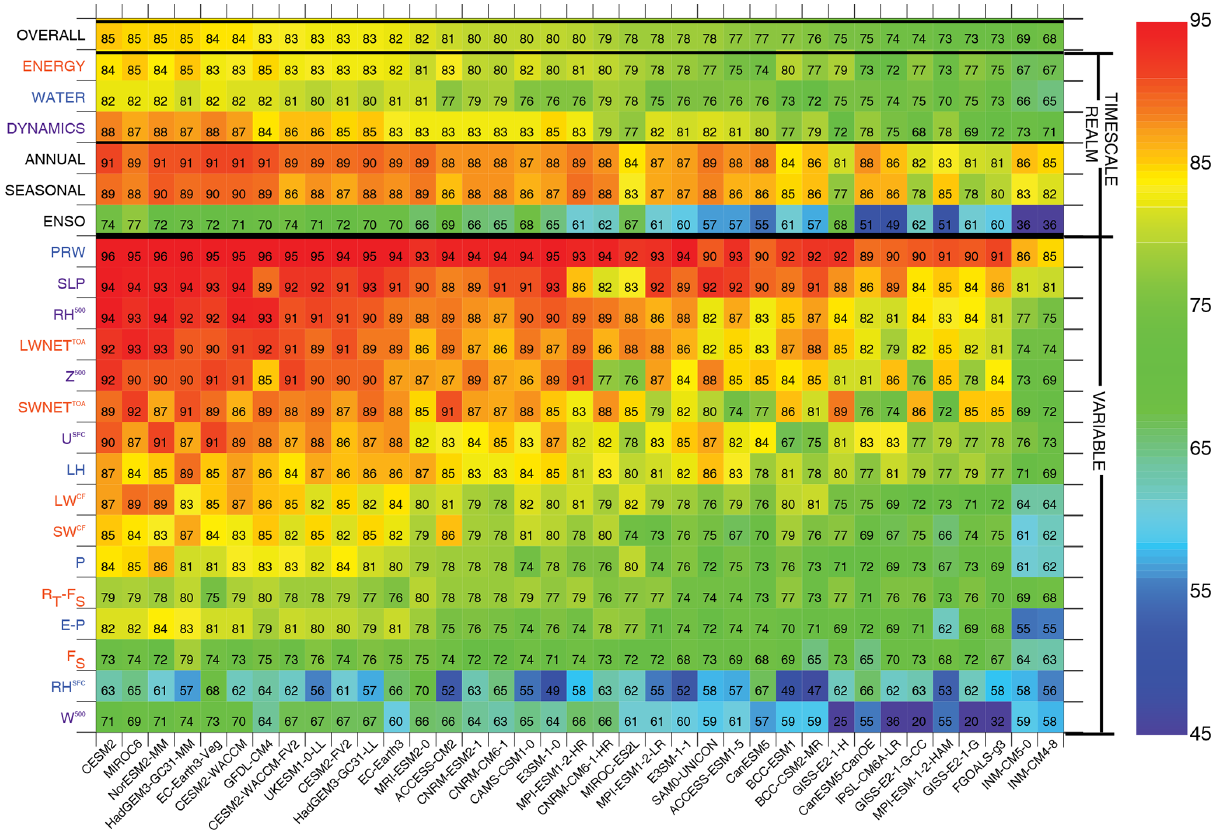
Figure 4. As in Fig. 2 except for historical simulations submitted to the CMIP6